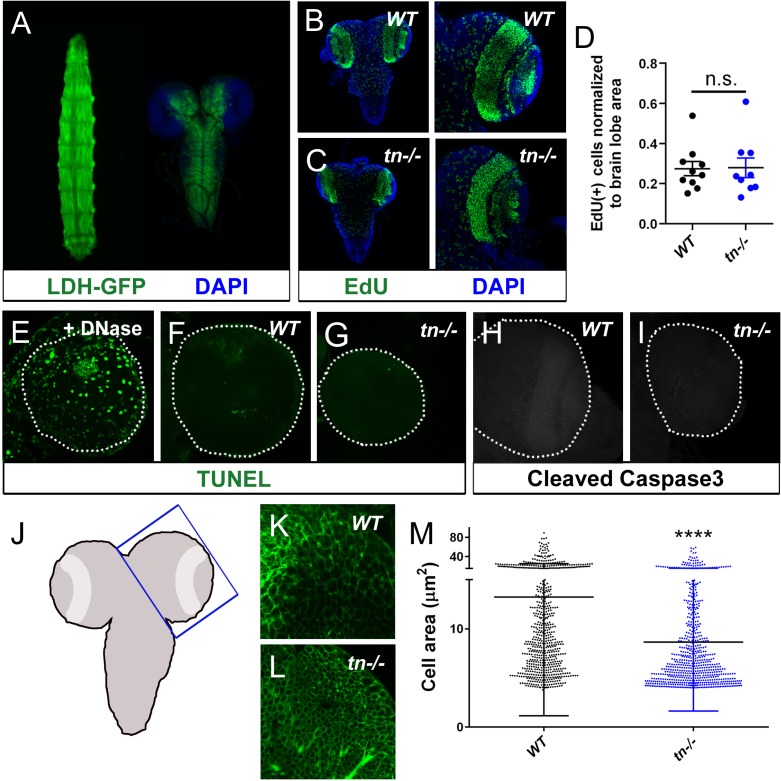
Cell proliferation or cell death are not affected in tn-/-.(A) Endogenous LDH-GFP (green) expression in the somatic muscles of whole larvae (left) and isolated larval brain (right). DAPI (blue) is used to visualize the entire brain lobe. (B,C) EdU incorporation (green) in whole larval brains (left panels) or individual brain lobes (right panels) reveals no difference in the proliferative capacity of neuroblasts. DAPI (blue) demarcates the outlines of each tissue. (D) Scatter plot depicting the average number of EdU(+) cells normalized to the brain lobe area. N ≥ 9. (E–I) Individual brain lobes (white dotted outline) visualized with TUNEL (E–G) or cleaved caspase3 immunostaining (H,I) to assay apoptotic cells. There is no difference in the number of TUNEL(+) or Caspase3(+) cells in WT or tn-/-. Tissue treated with DNase served as a positive control for TUNEL labeling (E). (J–M) Analysis of cell size in the larval brain lobe. (J) Schematic of larval brain. Blue box indicates region of brain lobe images. (K,L) Representative micrograph of phalloidin-stained cells in the lobe region of WT (K) or tn-/- brains (L). (M) Quantification reveals various sizes of neuroblasts in brain lobe tissue. Overall cell size is reduced upon loss of TRIM32. N ≥ 300 cells in 10 independent brain lobes of each genotype. Mean +/- SD (****, p<0.001; n.s., not significant).